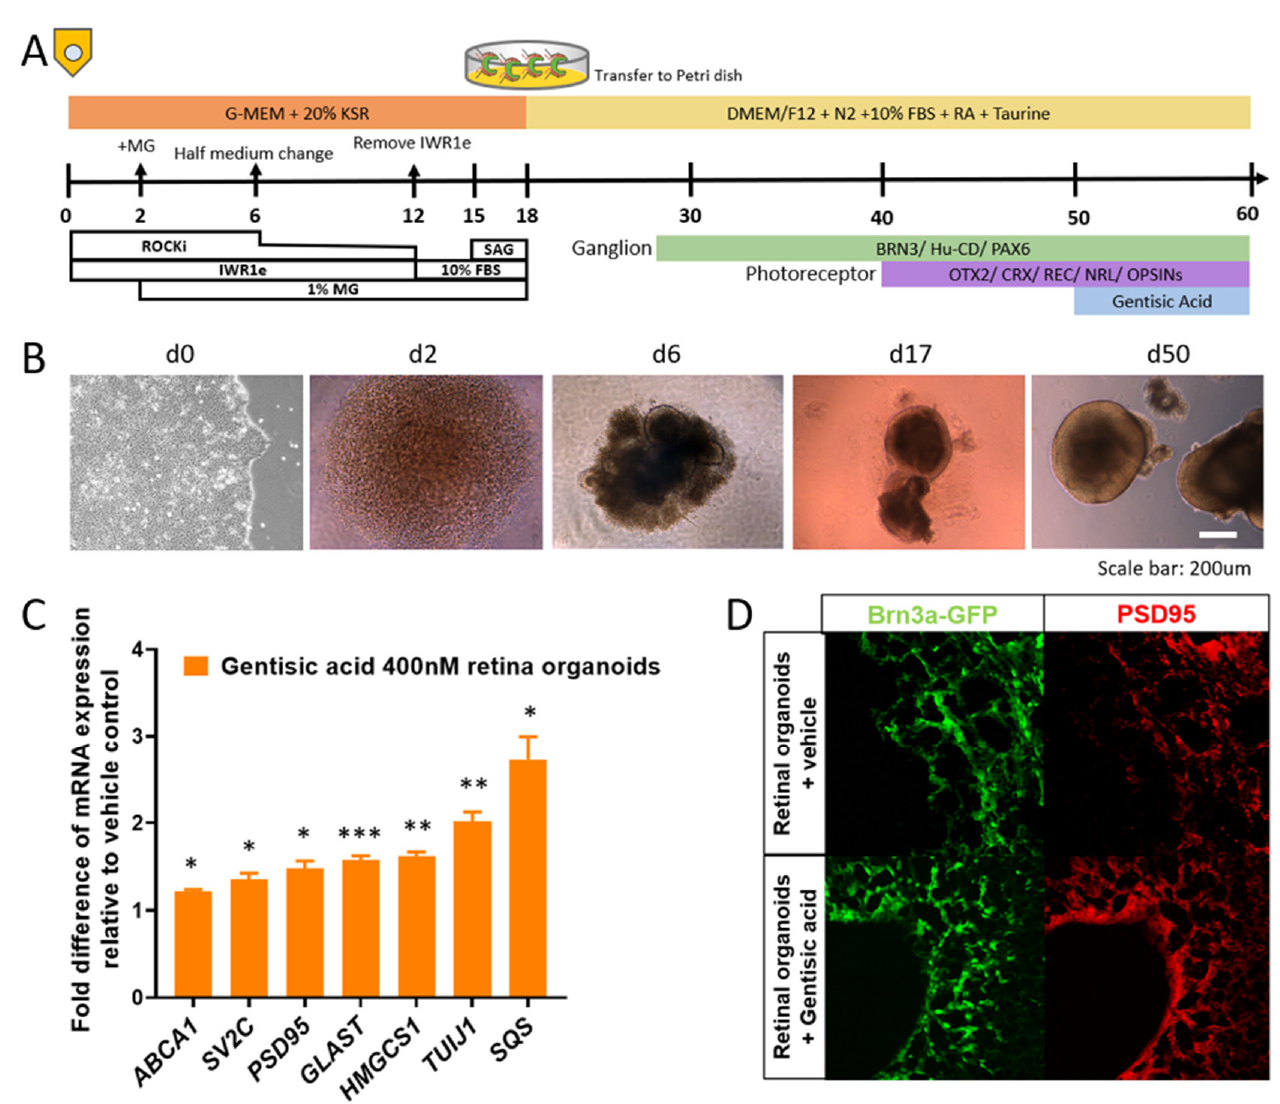
Figure 1. Administration of gentisic acid (GA) increases cholesterol synthesis and accelerates RGC maturation and synaptic plasticity in retinal organoids: ( A ) Retinal organoid production and treat- ment timeline with GA application on days 50–60; ( B ) Progression of growth from iPSC to retinal organoids; ( C ) RT-PCR analysis reveals significantly increased expression of cholesterol synthesis- related markers ( HMGCS1, SQS ), synaptic plasticity-related proteins ( SV2C, PSD95, GLAST, and TUJ1 ), and ABCA1 in GA-treated retinal organoids when compared to conventionally grown retinal organoids. * p < 0.05, ** p < 0.01, and *** p < 0.001 ( D ) Representative, confirmatory immunofluores- cence images show increased expression of a synaptic plasticity-related marker (PSD95) and a more matured organization of Brn3a-GFP + RGC after GA supplementation .